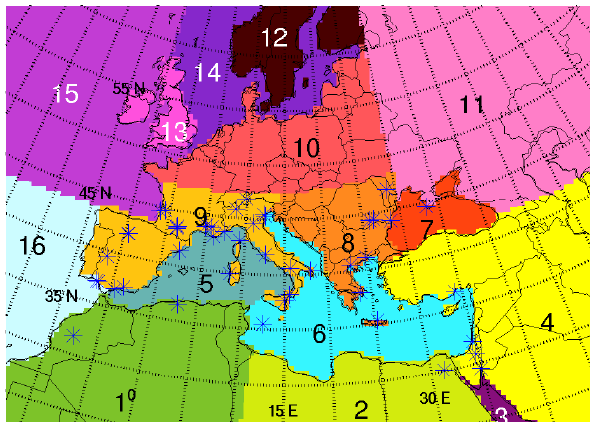
Fig. 1. Domain of study over the Mediterranean basin. The 47 studied AERONET stations are indicated with a blue star. Colors on the map define regions (numbered from 1 to 16) for applying region-averaged CALIOP aerosol vertical profiles in the final AOD field product (see Section 3.3 and Table 4).